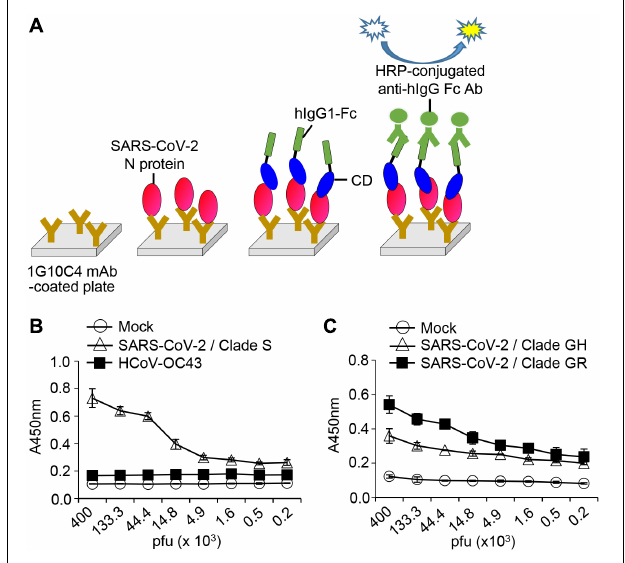
FIGURE 7 | Detection of SARS-CoV-2 in cell culture media using SARS-CoV-2 N protein-specific monoclonal antibody and recombinant SARS-CoV-2 Spike CD-Fc protein. (A) Schematic of the ELISA. (B) SARS-CoV-2 clade S and HCoV-OC43 and (C) SARS-CoV-2 clade GH and clade GR in cell culture supernatants were lysed with cell lysis buffer and serially diluted in PBST. These virus lysates were added into 96-well immunoplates coated with SARS-CoV-2 N protein-specific monoclonal antibody. After incubation for 2 h at room temperature, recombinant SARS-CoV-2 Spike CD-Fc protein was added, and then HRP-conjugated anti-human IgG Fc antibody was added to each well. The amount of SARS-CoV-2 N protein in each well was determined by